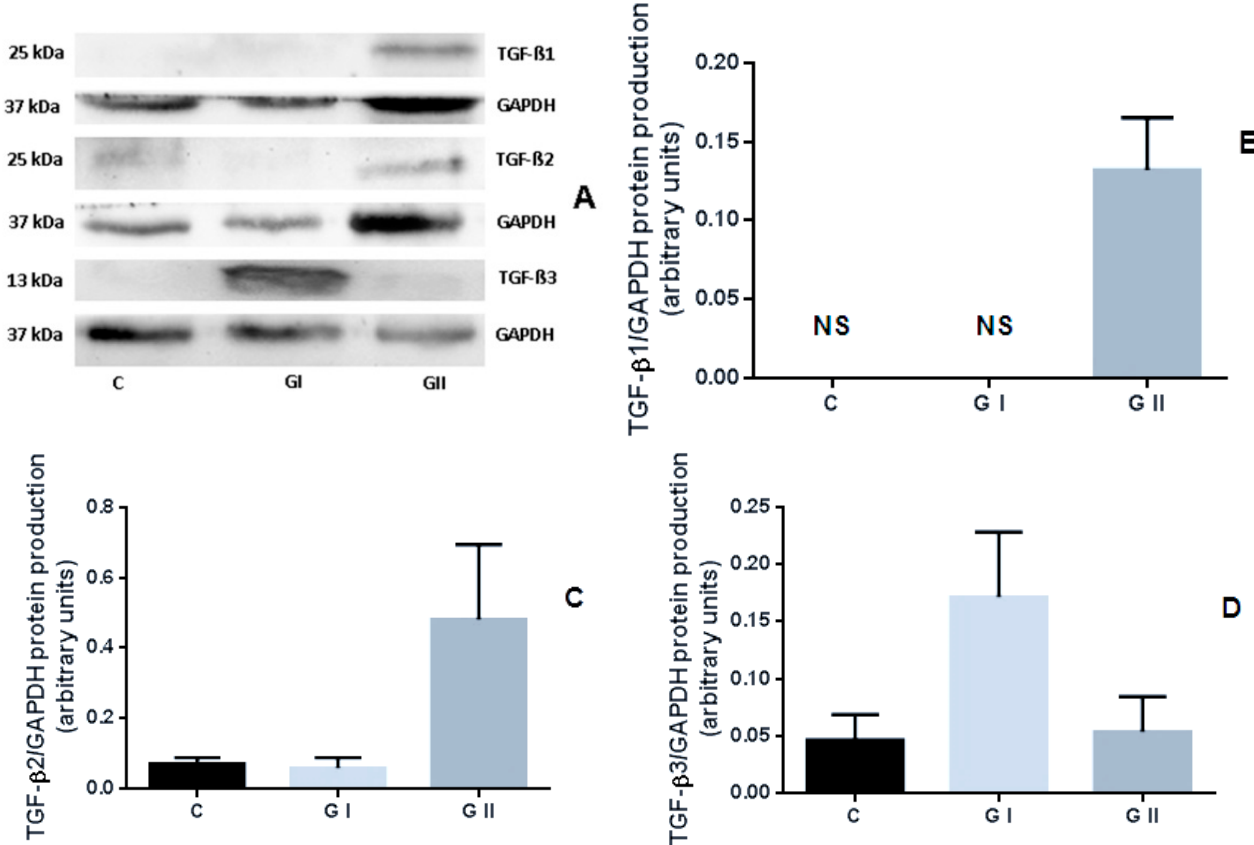
Figure 3. TGF- β 1 ( B ), TGF- β 2 ( C ), and TGF- β 3 ( D ) protein production in bitches’ endometrium samples with cystic endometrial hyperplasia (GI) and pyometra (GII) compared to the physiological endometrium ( C , control group). ( A ) Representative blots for TGF- β and GAPDH. The data were normalized to glyceraldehyde-3-phosphate dehydrogenase (GAPDH). The bars represent the mean ± SEM, in arbitrary units. The TGF- β 1 ( B ) and TGF- β 2 ( C ) signals were identified as mature dimers (25 kDA); for the TGF- β 3 ( D ) signal, mature monomer (13 kDA) was detected. NS, no protein signal.